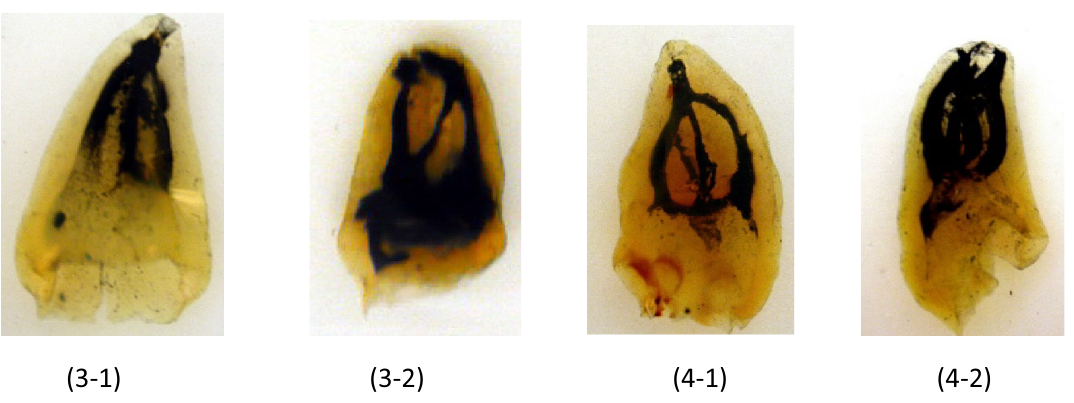
Figure 3. The eight types of Vertucci’s canal configuration in cleared mandibular third molars.